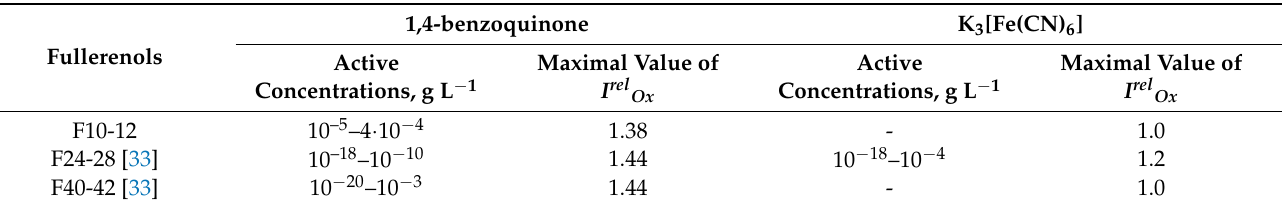
Table 2. Range of active concentrations and maximal values of I rel Ox for fullerenols in model oxidizer solutions of 1,4- benzoquinone and K 3 [Fe(CN) 6 ].